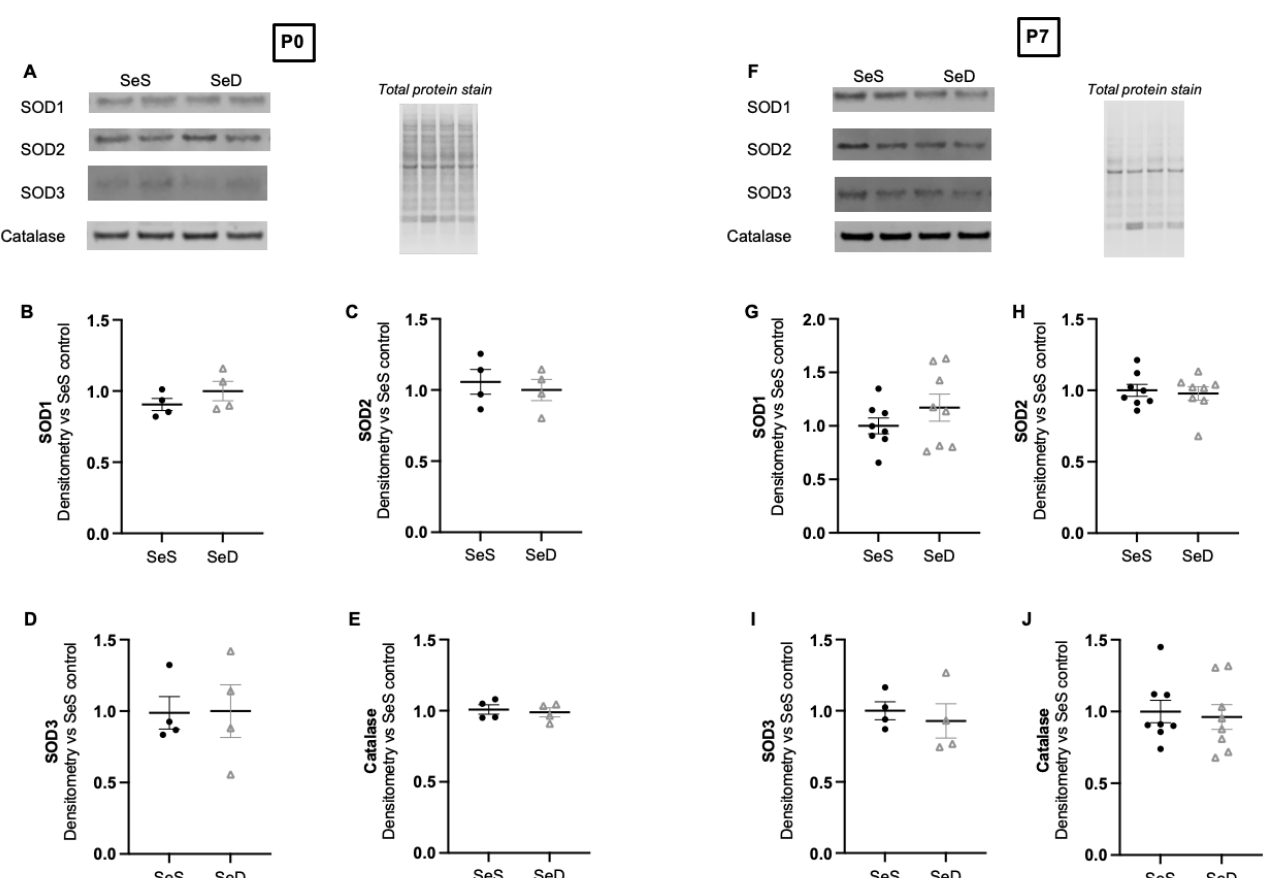
Figure 7. Se deficient neonates have unaltered protein content of the SODs and catalase at P0 and P7 C57Bl/6 mice were placed on diets that differed only in Se content, either 0.4 ppm or <0.01 ppm of sodium selenite, through pregnancy and lactation. Pulmonary organ homogenate was evaluated on day of birth (P0) and postnatal day 7 (P7). ( A ) Representative Western blots of pulmonary SOD1, SOD2, SOD3 and catalase for SeS P0 samples and SeD P0 samples, Densitometric analysis of ( B ) SOD1, ( C ) SOD2, ( D ) SOD3, and ( E ) Catalase protein content expression at P0. ( F ) Representative Western blots of pulmonary SOD1, SOD2, SOD3 and catalase for SeS P7 samples and SeD P7 samples, Densitometric analysis of ( G ) SOD1, ( H ) SOD2, ( I ) SOD3, and ( J ) Catalase protein content expression at P7. Results are normalized to total protein stain and expressed as a ratio to SeS mice. N = 4–8 for all groups. Data and presented as mean (±SEM).